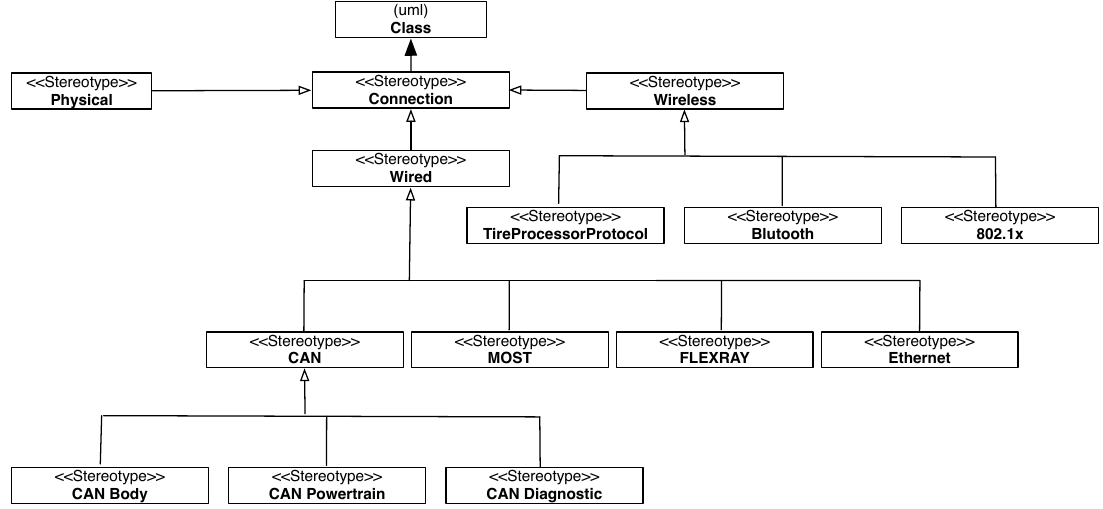
Figure 5. Connections in the Automotive